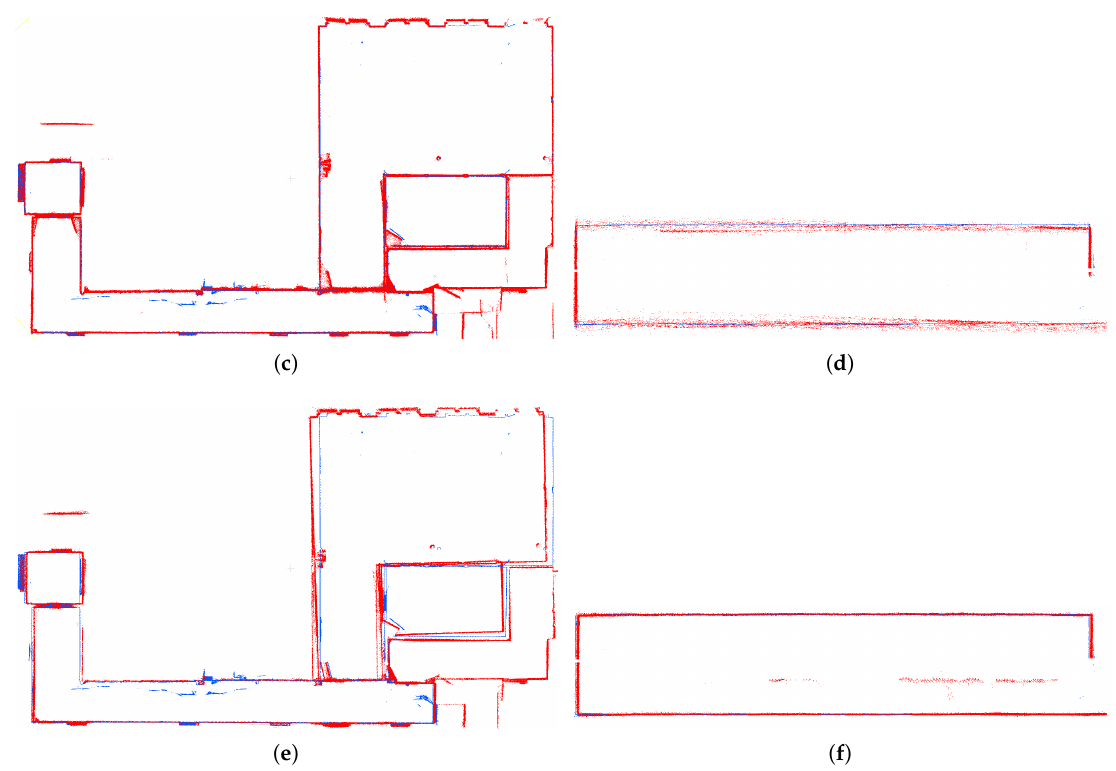
Figure 27. Comparison of reconstructions provided by dual LiDAR system—floor plan top view ( a ) and side view of the corridor ( b )—with the reconstruction built using only single horizontally ( c , d ) or vertically ( e , f ) positioned Velodyne LiDAR. The reconstructions are red colored with ground truth displayed in